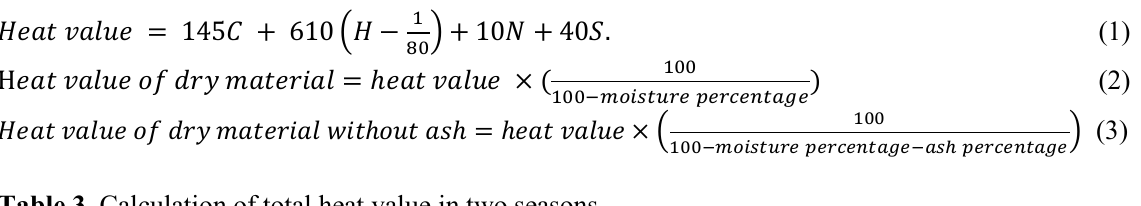
Autumn The first The second scenario scenario